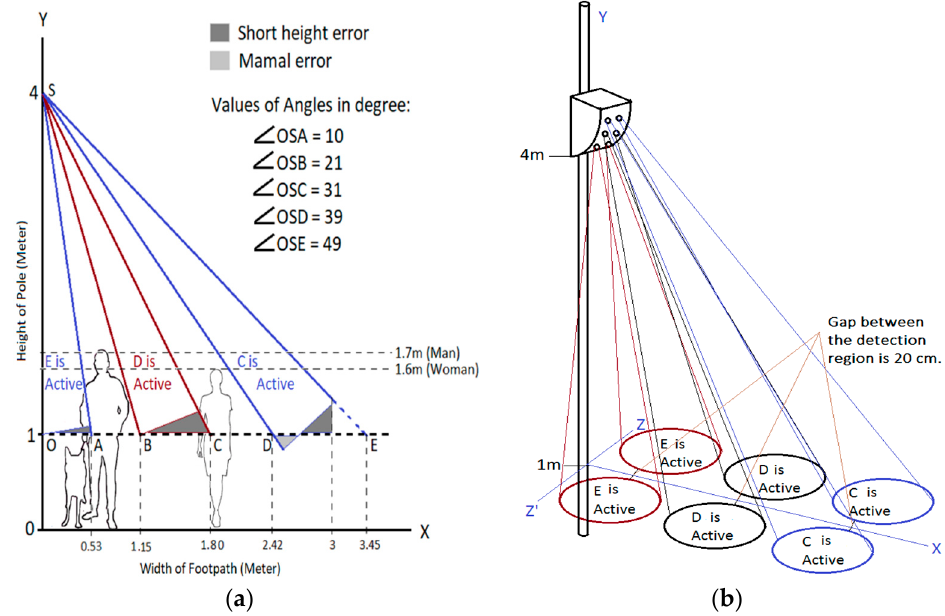
Figure 2. ( a ) Height of the system and counting mechanism, ( b ) 3-D view of the detection regions of the PIR sensors for the proposed system.